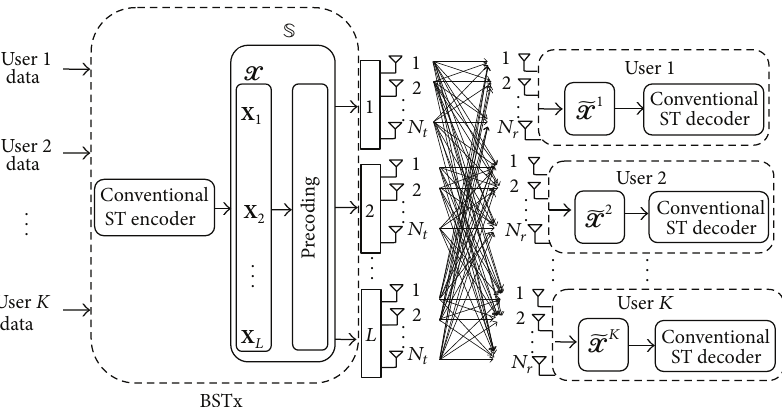
Figure 4: Rateless space time block code for massive multiuser MIMO